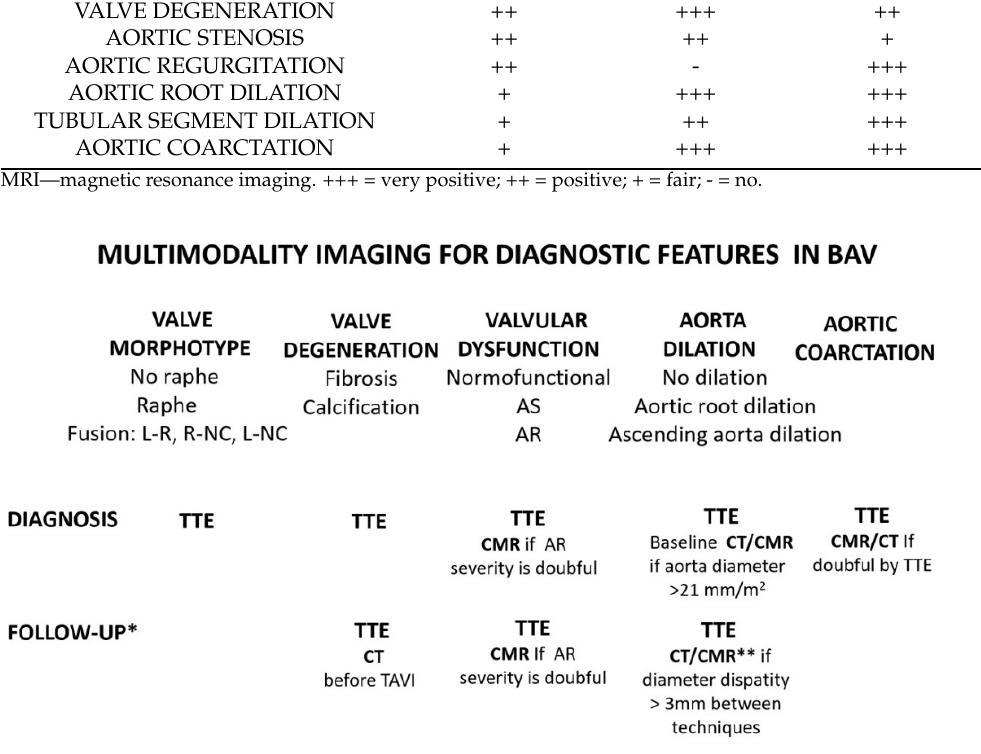
Table 1. Comparison of imaging modalities for diagnostic features of bicuspid aortic valve. TTE— transthoracic echocardiography; CT—computed tomography. TTE CT MRI +++ ++ +++ +++ +++ ++ ++ +++ ++